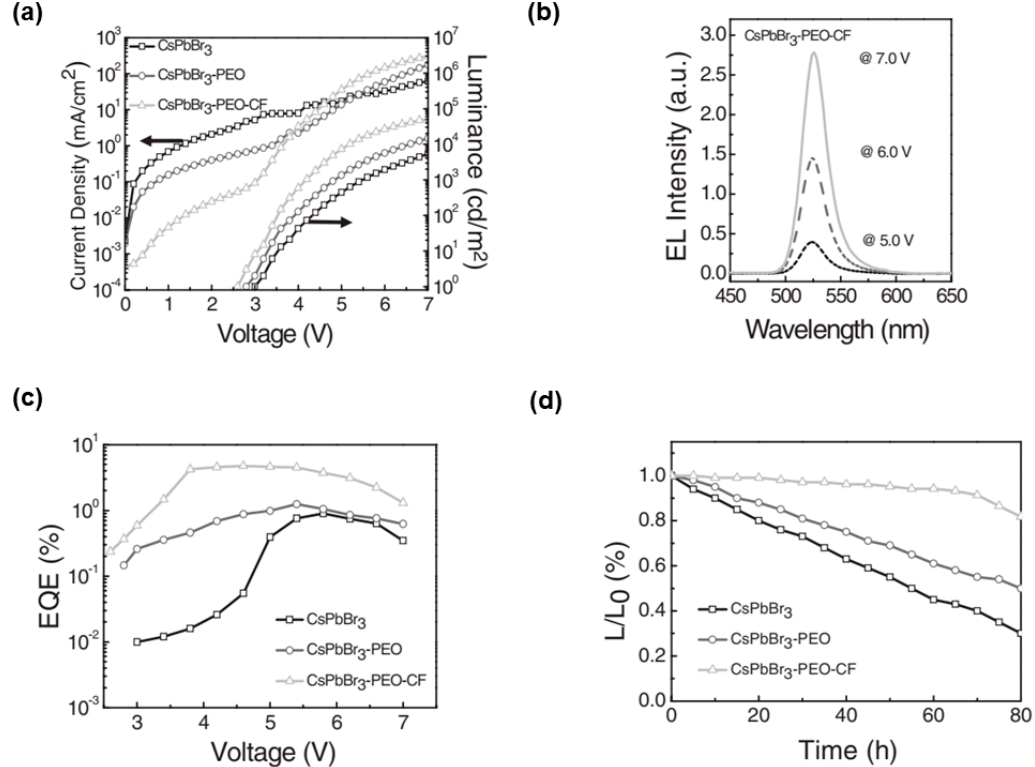
Figure 2. ( a ) Current density and luminance. ( b ) EL spectra of CsPbBr 3 -PEO-CF film-based device. ( c ) External quantum efficiency (EQE). ( d ) Stability of PeLEDs based on pristine CsPbBr 3 , CsPbBr 3 -PEO, and CsPbBr 3 -PEO-CF. Reproduced from reference [124]. John Wiley and Sons, 2017.